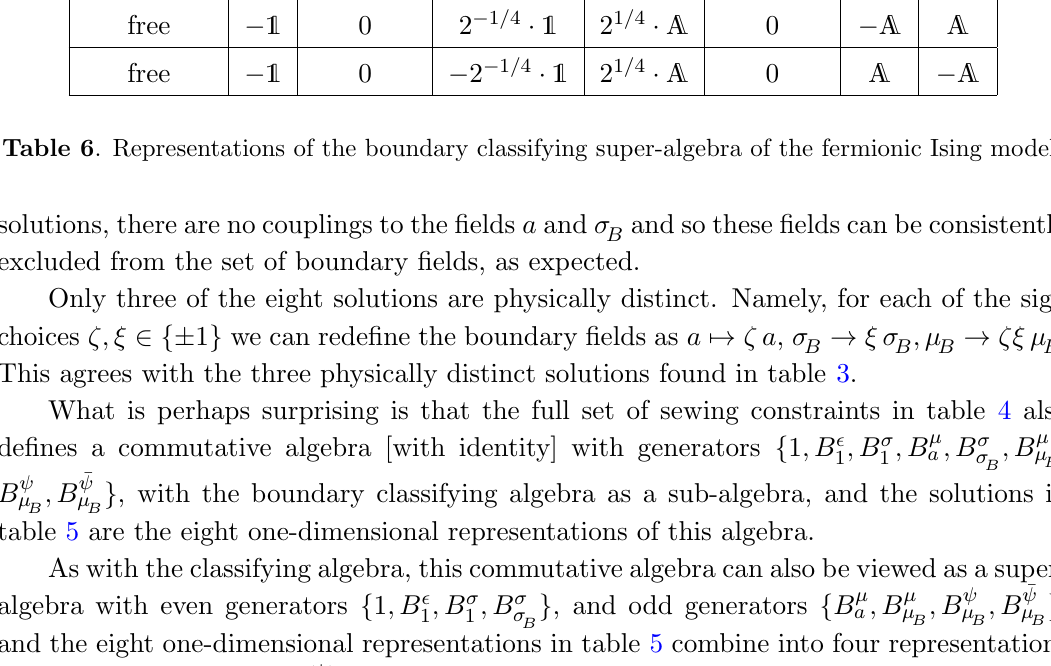
and so these (cid:12)elds can be consistently B